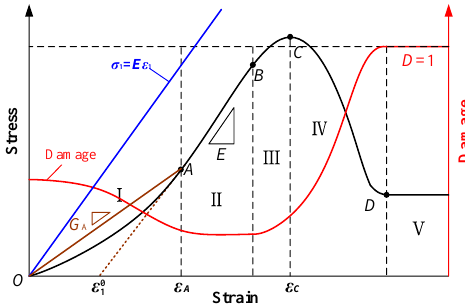
Figure 7. Stress – strain-damage curves of rock-like materials during the compression process. Figure 7. Stress–strain-damage curves of rock-like materials during the compression